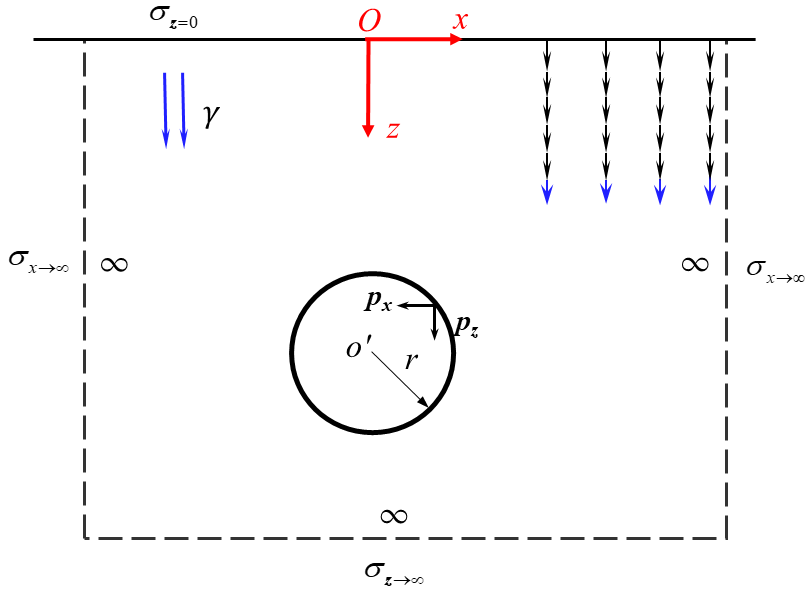
5 of 19 Figure 2. Flowchart of the calculation. 3. Analytical Solutions of Stress for Tunneling Adjacent to Pile group